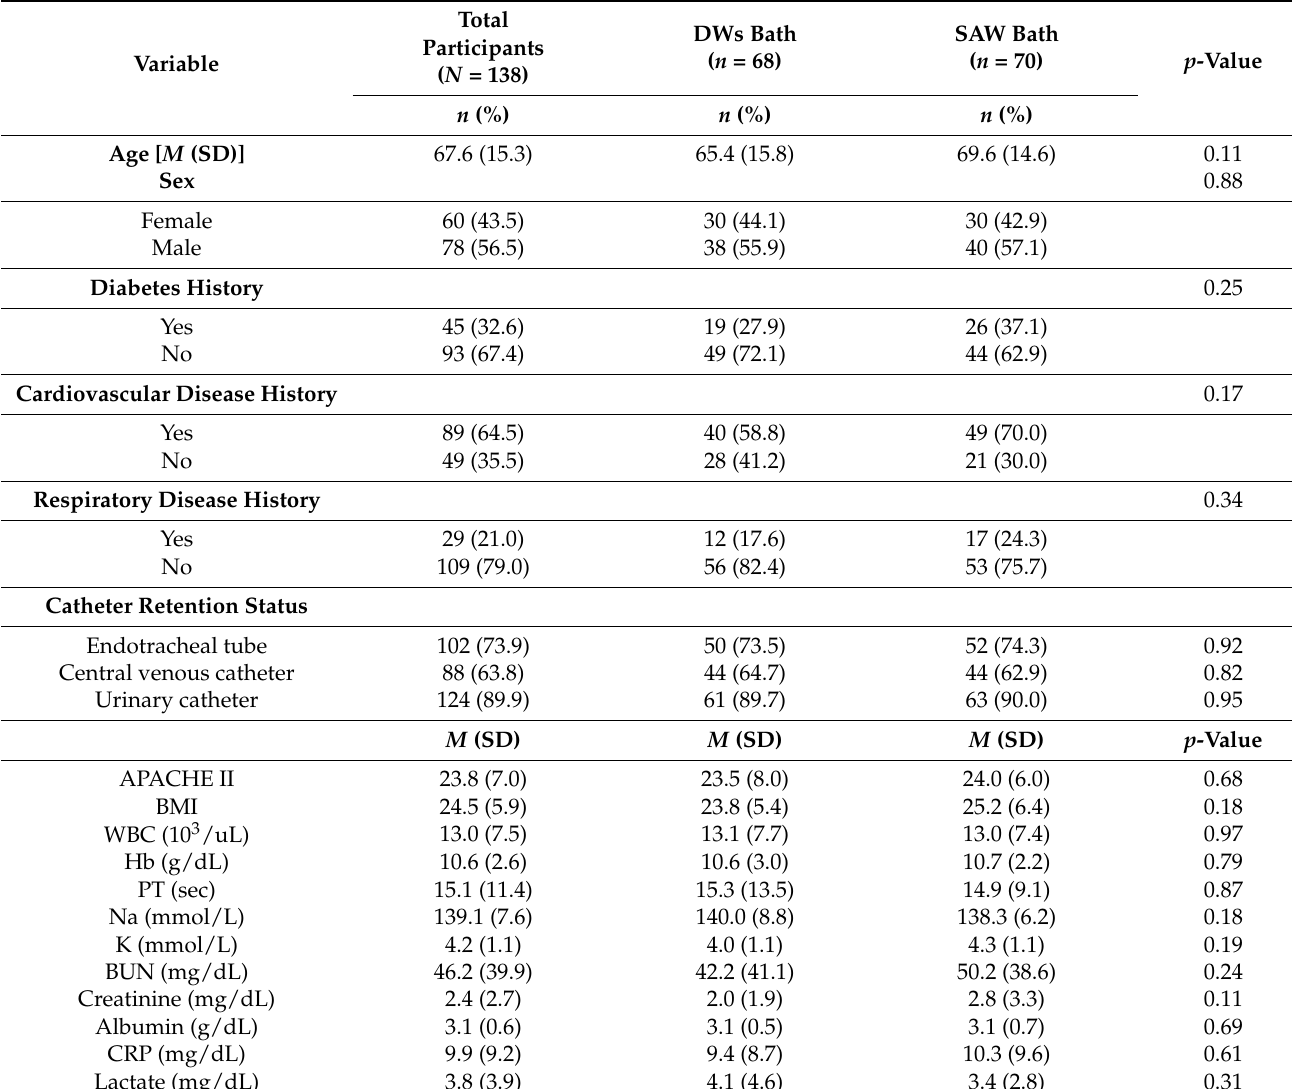
Table 1. Comparison of the participants’ general characteristics.